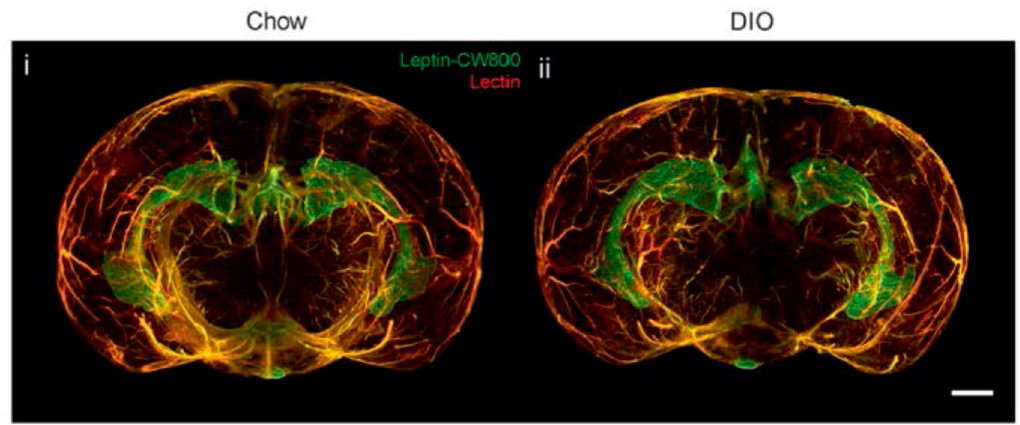
Figure 1. Three-dimensional reconstruction of the brain, indicating the accumulation of fluorescent leptin (leptin-CW800) in the median eminence (ME) and choroid plexus (CP) of lean (Chow, standard diet) (i) and diet-induced obesity (DIO) (ii) mice. From [34], visit http://creativecommons.org/licenses/by/4.0/.